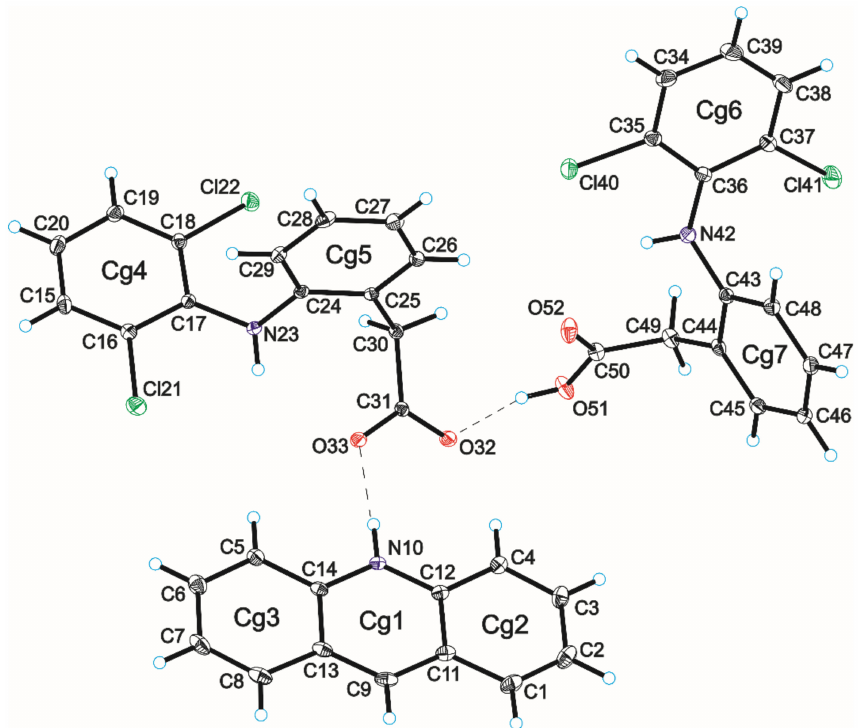
Figure 1. Molecular structure of compound 1 showing the atom-labelling scheme (Cg1, Cg2, Cg3, Cg4, Cg5, Cg6, and Cg7 denote the ring centroids; hydrogen bonds are represented by dashed